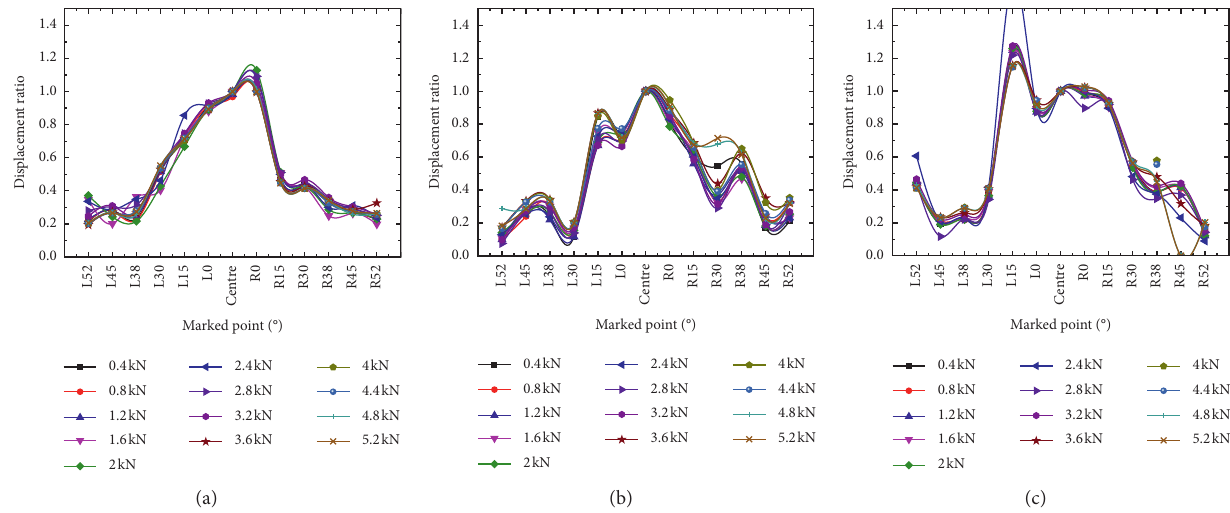
Figure 17: Distribution curve of soil displacement according to diffusion angle under different loads at 30 ° . (a) The 0 b row. (b) The 0.75 b row. (c) The 1.50 b row.